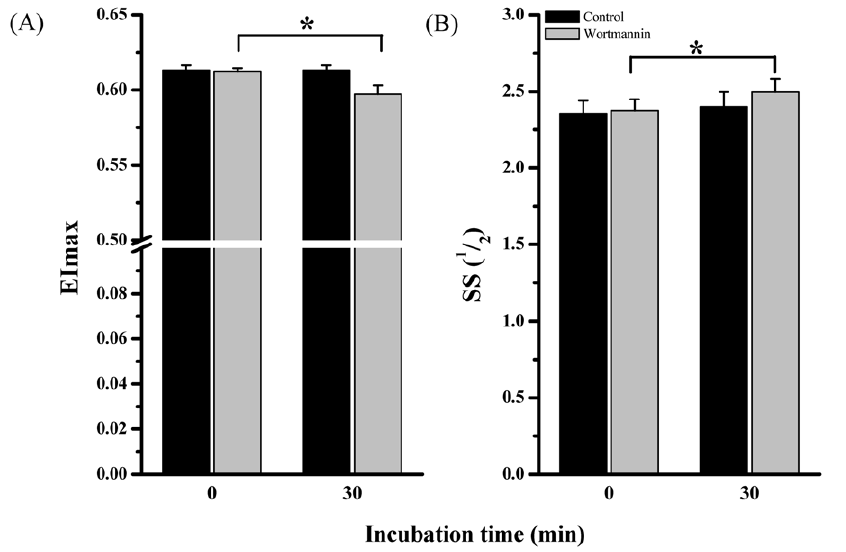
Figure 8. Influence of wortmannin on RBC deformability. RBC deformability was measured before and after 30 min incubation with wortmannin and PBS, as control. (A) No difference in EImax was observed after PBS treatment. After wortmannin incubation EImax was significantly decreased ( P , 0.05). (B) SS K was unchanged after PBS treatment but significantly increased after wortmannin application, indicating decreased deformability ( P , 0.05) Data are presented as mean 6 S.E.M of